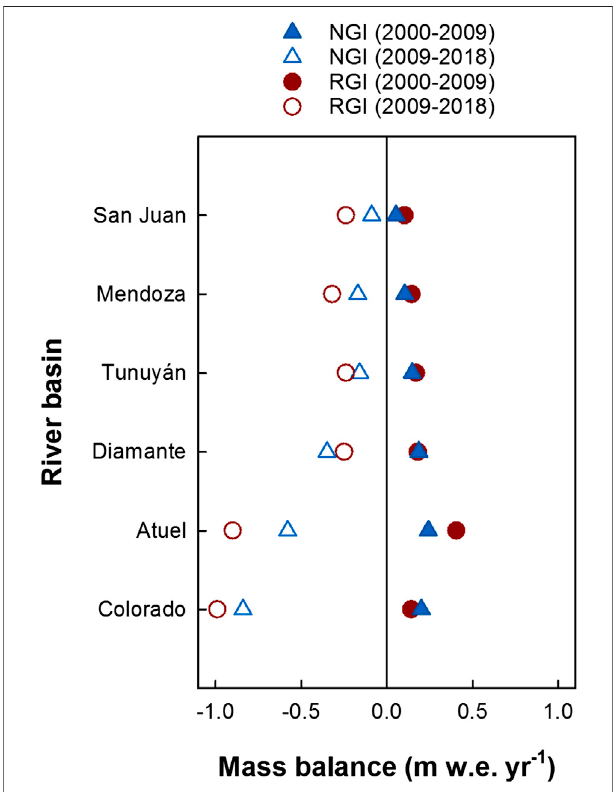
FIGURE 8 | Different mass balance rates in the Central Andes ice masses based on the NGI and RGI version 6.0 inventories.